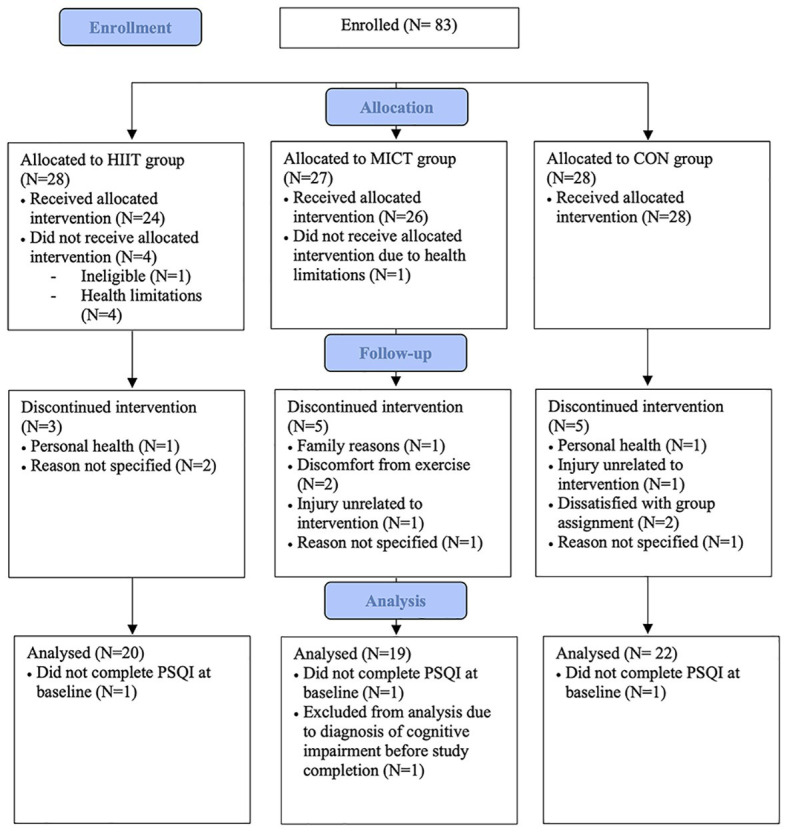
Flow of participants through study (Kovacevic et al., 2019).